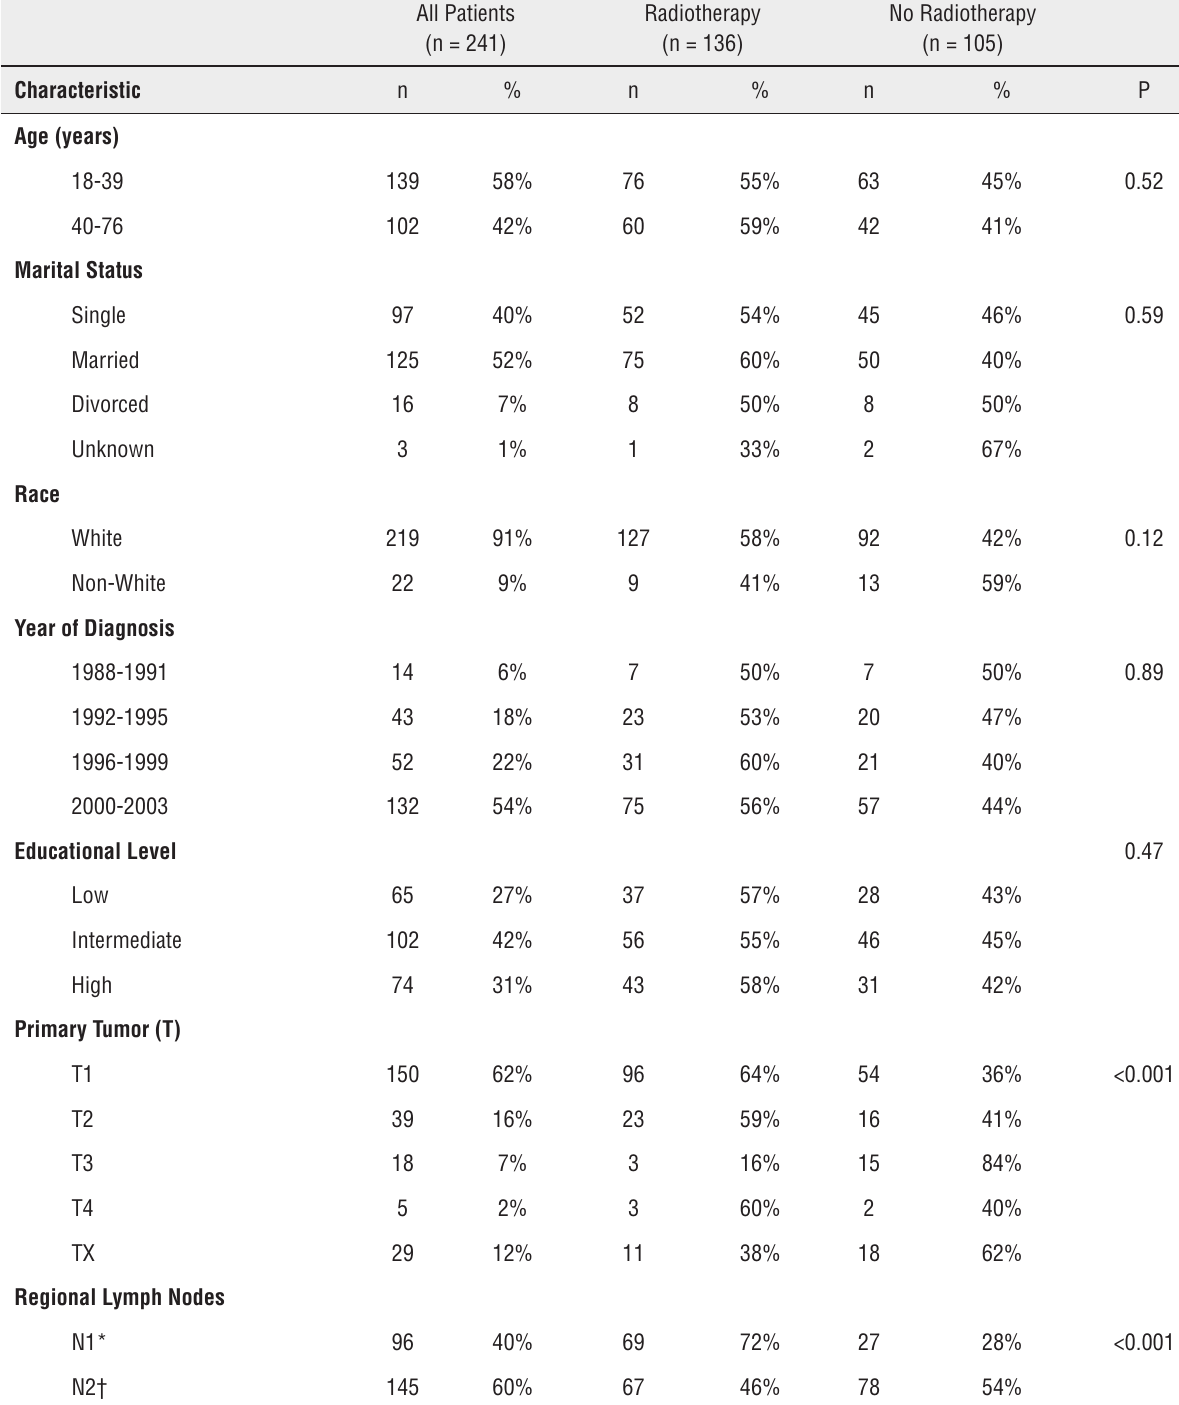
Table 1 - Characteristics of Stage IIA and IIB Testicular Seminoma